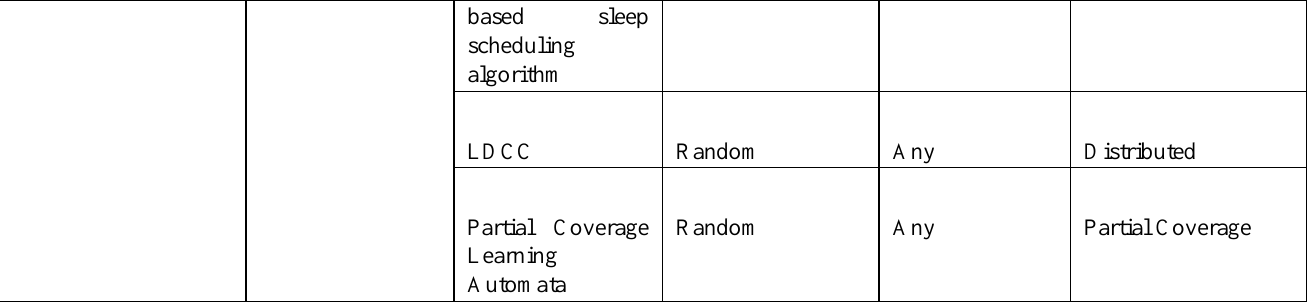
Table 2. Comparative analysis of Target Coverage Techniques[Scheduling Algorithms]